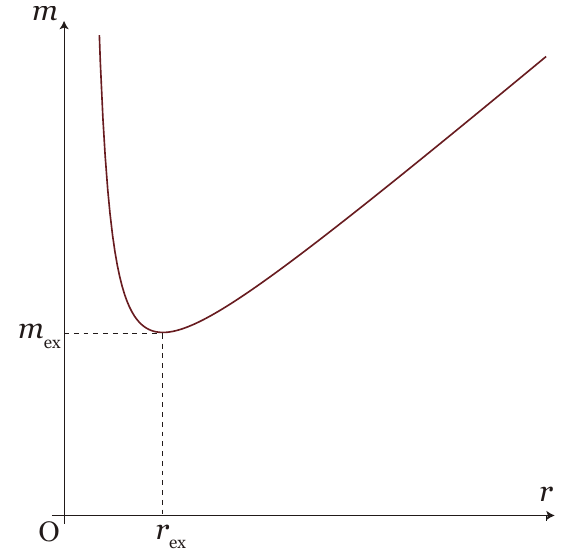
Figure 3 . The form of m = m h ( r ) given by eq.